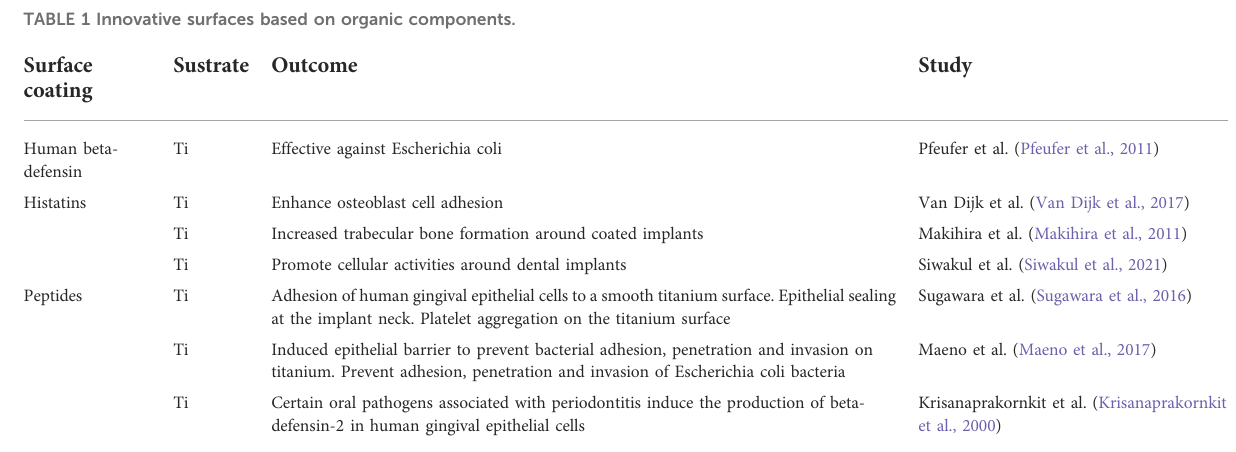
TABLE 1 Innovative surfaces based on organic